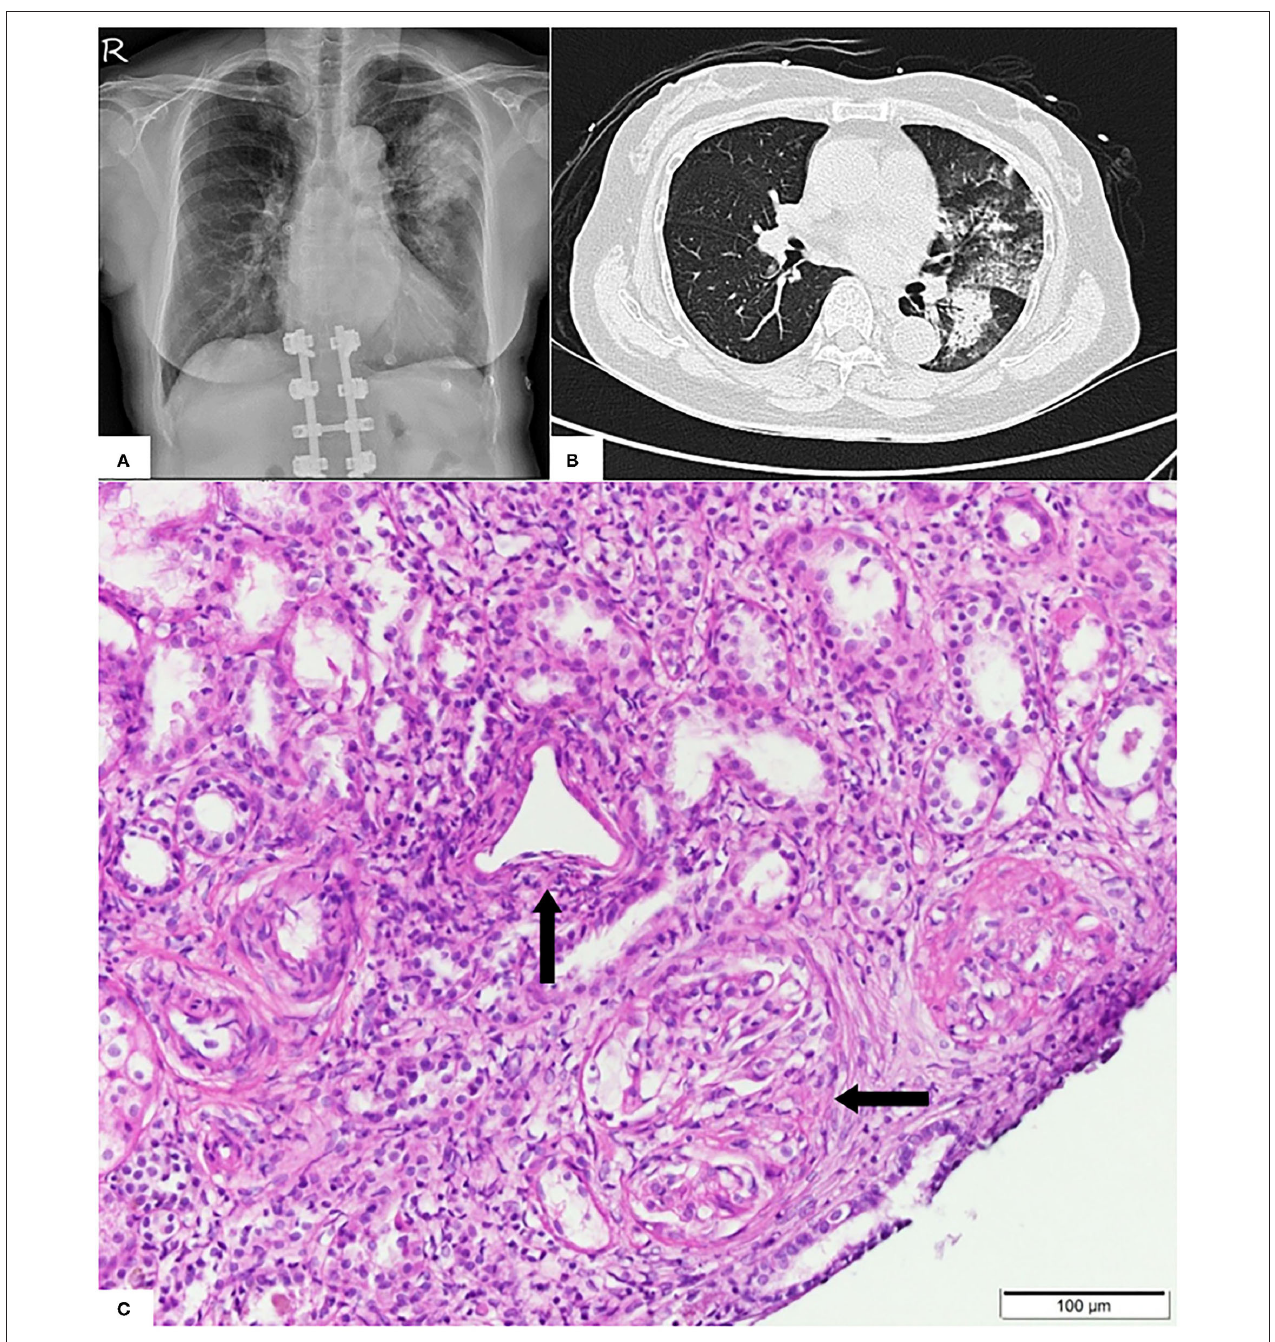
FIGURE 1 | (A) Pulmonary X-ray showing dense patchy consolidations in the left upper lung field. (B) Pulmonary computed tomography revealing peribronchial consolidations and ground glass opacities in the bilateral lung field, predominantly in the left upper lobe. (C) Light microscopy showing predominant vasculitis (parallel arrow) with pauci-immune crescent glomerulonephritis (horizontal